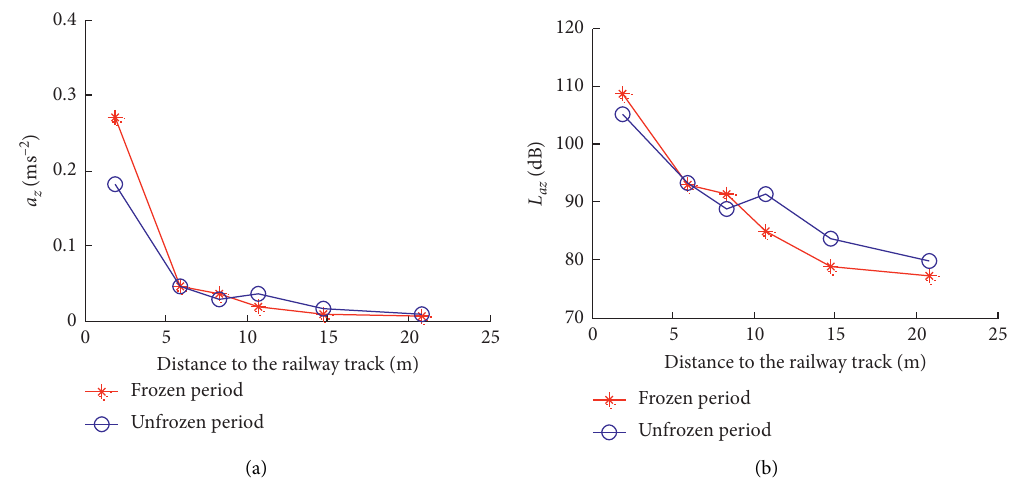
Figure 6: Attenuation mechanism of the vibration response during different frozen periods (passenger train K554): (a) vibration ac- celeration; (b) vibration